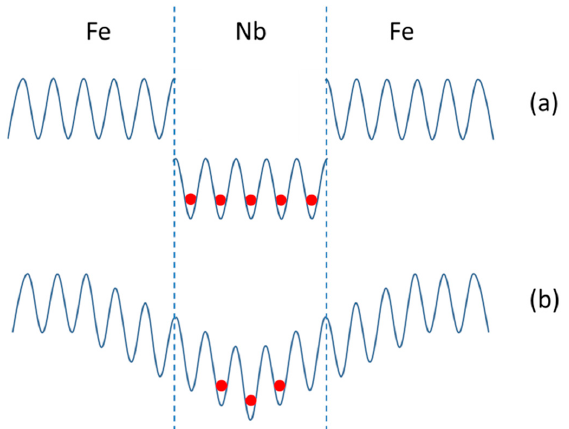
Figure 2. Schematic characteristic of the potential energy (chemical potential) of hydrogen atoms at a metal/metal-hydride/metal interface. Example: Fe (small solubility for hydrogen) and Nb (large solubility for hydrogen). The red dots indicate preferred hydrogen absorption sites. ( a ) Fe and Nb layers separated; ( b ) Fe and Nb layers in contact.